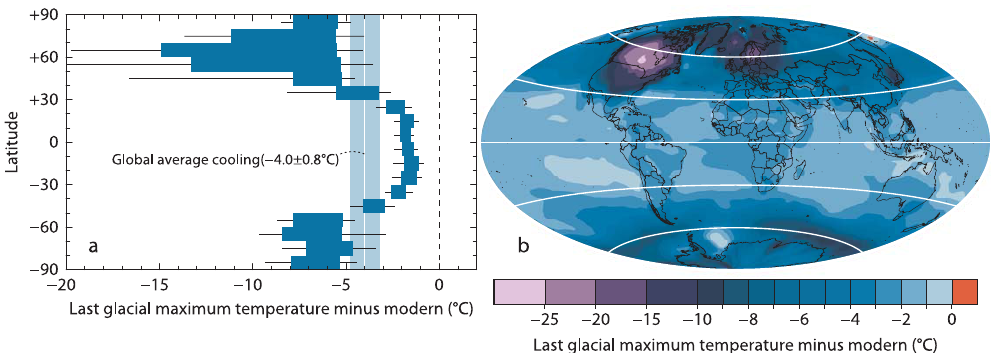
Figure 1. The change in surface air temperatures from the last glacial maximum to the preindustrial era (gridded data from Annan and Hargreaves, 2013). (a) Percentile ranges of temperature changes since the last glacial maximum for 10 degree latitudinal bands. Blue shading marks the 25th–75th percentile range; thin horizontal lines mark the 10th–90th percentile range. The grey band shows the globally averaged estimate of temperature change since the last glacial maximum of − 4.0 ± 0.8 ◦ C. (b) Gridded surface air temperature anomaly from the last glacial maximum to the preindustrial era (data from Annan and Hargreaves,